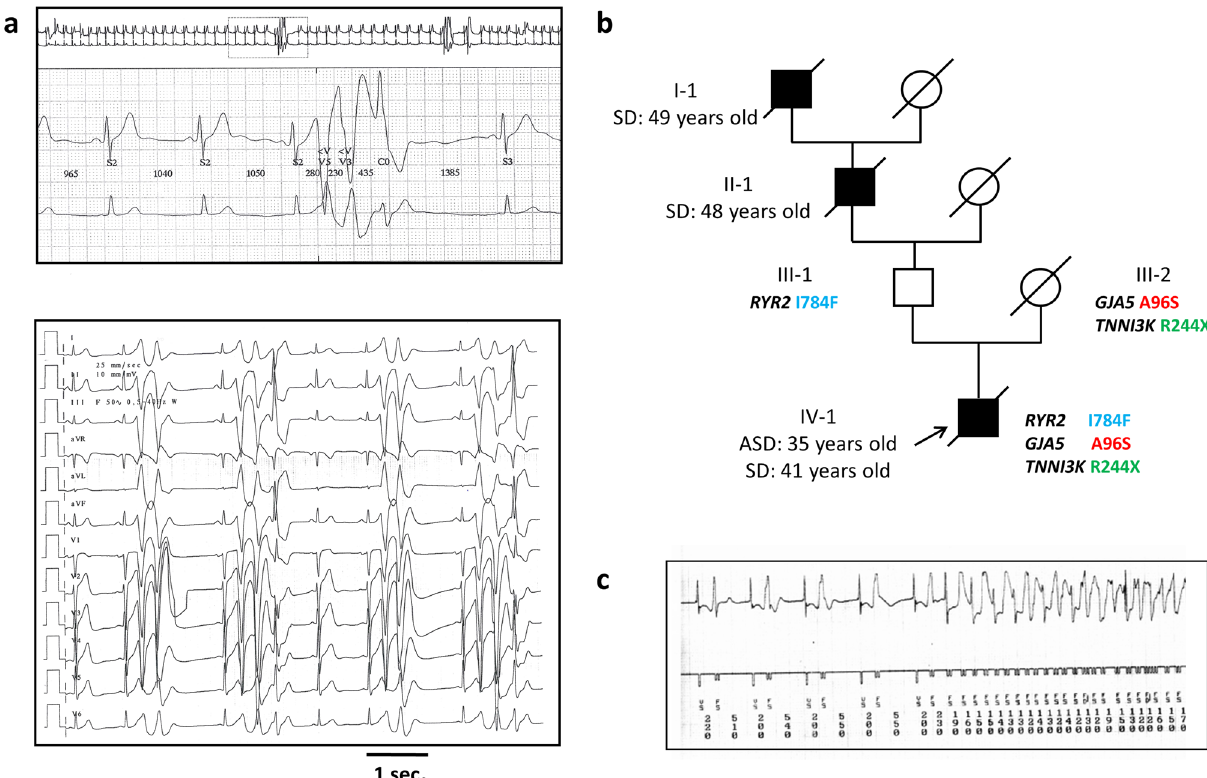
Figure 1. Pedigree and segregation of three variants. ( a ) Proband ECGs showing couplets and triplets of polymorphic ventricular beats. The coupling interval of the first ventricular premature beat is consistently very short: 280 ms. ( b ) Family pedigree and genotypes. All subjects were heterozygous carriers of the variants. Black symbols indicate individuals affected by sudden death, with the proband marked with an arrow, square: man, circle: woman, oblique bar: deceased, grey symbol: potentially affected individual, white symbol: clinically unaffected individual. SD: sudden death, ASD: aborted SD. ( c ) Polymorphic ventricular tachycardia and ventricular fibrillation recorded by ICD device the day of the proband